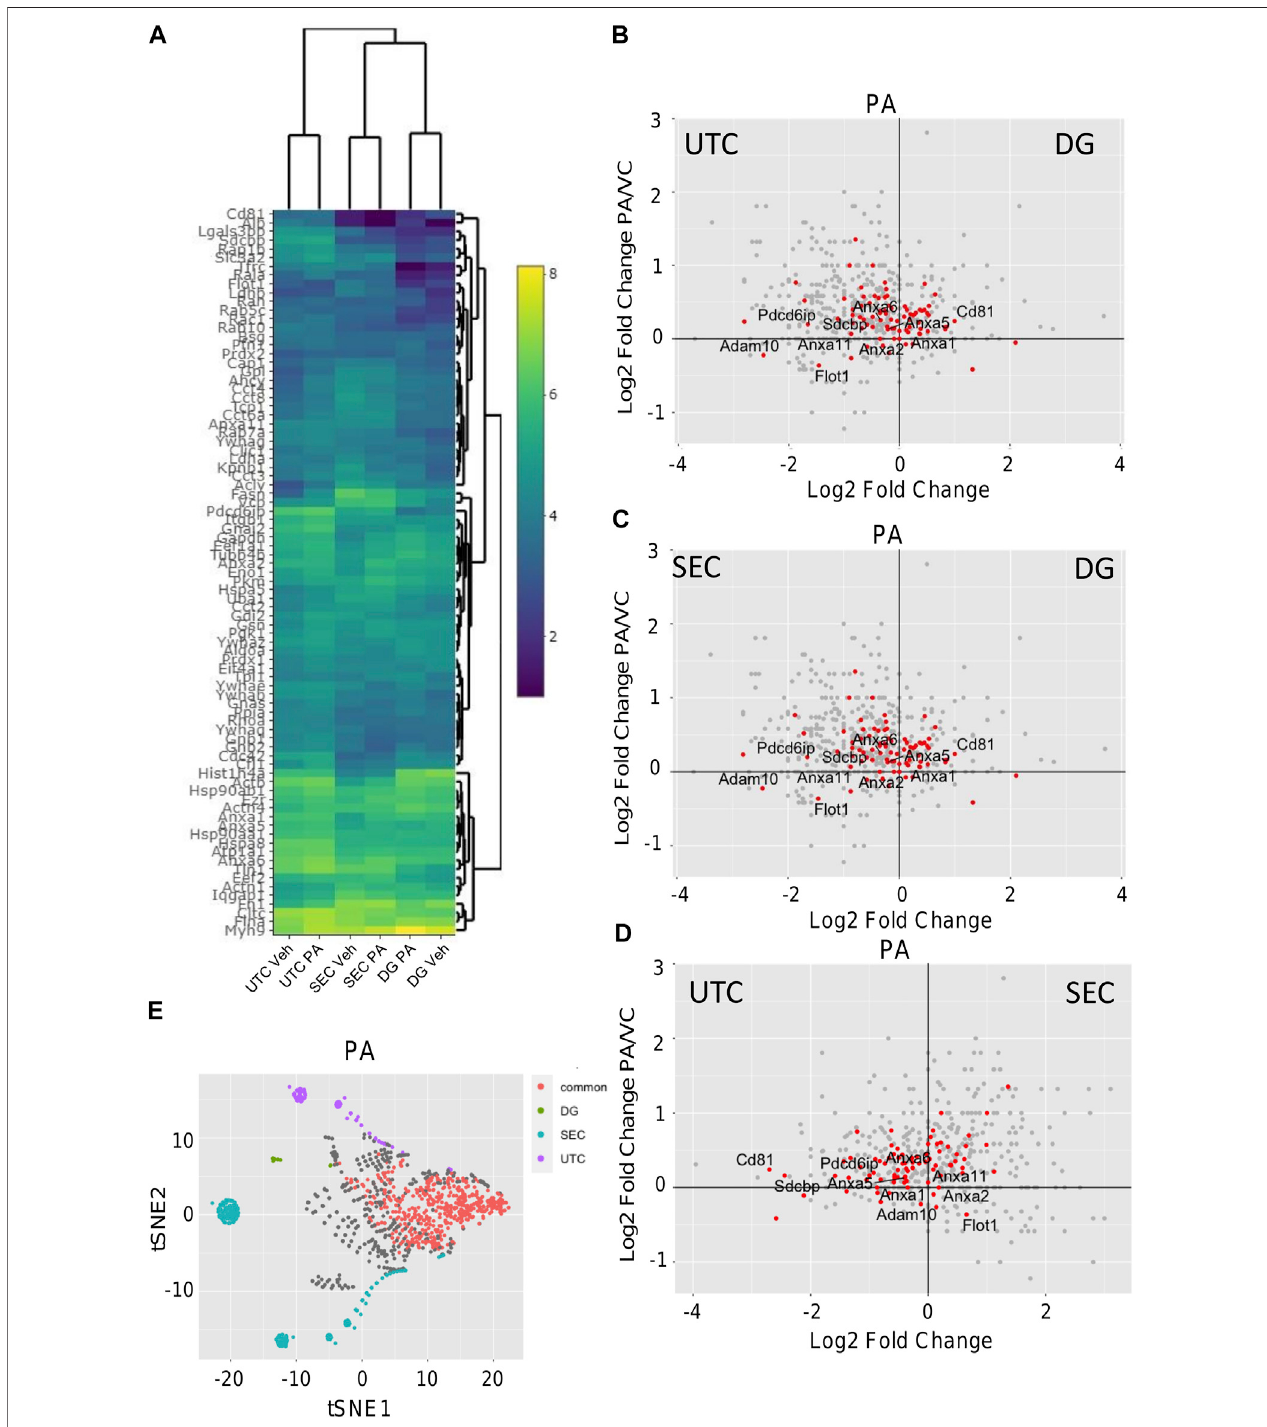
FIGURE2| ComparisonofEVproteomics. (A) Heatmapdepictingtheabundance83commonproteins(Log2proteinabundance)ofExoCartatop100 EVproteins detectedbyeachmethod. (B) Differentialexpressionofproteinsbyvolcanoplotwherethe x -axisrepresentsLog2(DGPA/UTCPA)andthe y -axisrepresentsLog2(UTC PA/UTC Veh). (C) Differential expression of proteins by volcano plots where the x -axis represents Log2 (DG PA/SEC PA) and the y-axis represents Log2 (UTC PA/UTC Veh). (D) Differential expression of proteins by volcano plots where the x-axis represents Log2 (SEC PA/UTC PA) and the y-axis represents Log2 (UTC PA/UTC Veh). For (B – D) , red dots indicate proteins from the top 100 ExoCarta EV proteins. (E) tSNE dimension reduction analysis was performed by Rtsne R package in all the data including missing values from PA stimulated EVs to depict the commonly and uniquely detected proteins by each of the three methods.